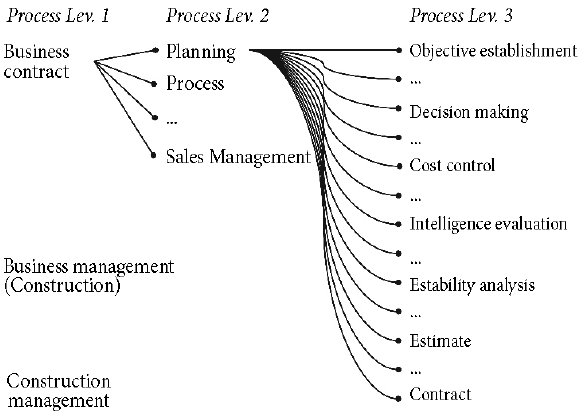
Figure 4. Example process hierarchy of the contract